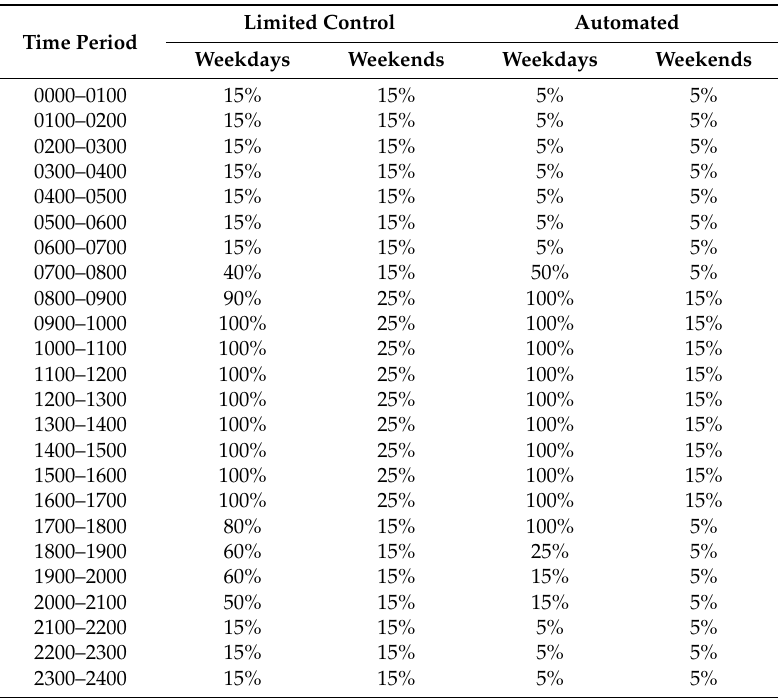
Table 2. Lighting hours profile utilized in the current study